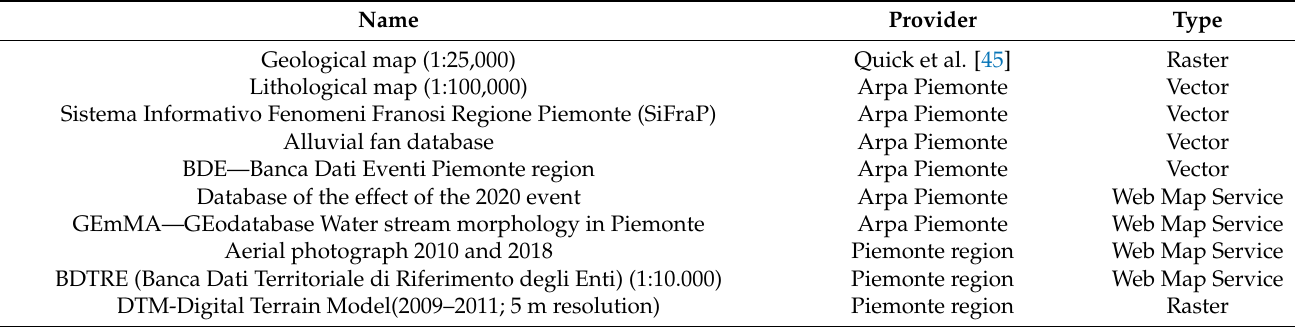
Table 2. Material used for the GIS